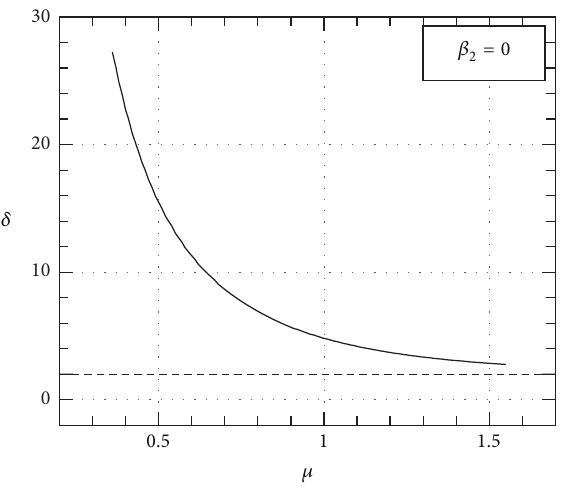
̇𝜙 Figure 4: Derivative difference 𝛿 of at the crossing point of the two lines of numerical integration as a function of the heat diffusion anisotropy strength 𝜇 (solid graph) in the case of isotropic surface tension (𝛽 2 = 0) . The approximate asymptote at 𝛿 = 2 is marked by a dashed